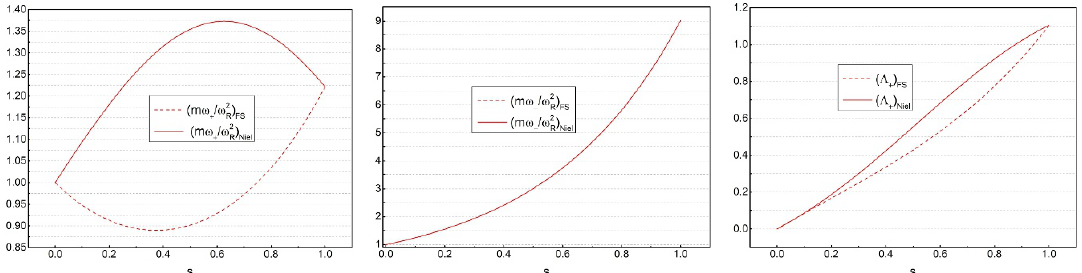
Figure 8 . Example of simple geodesics connecting the reference state to a same target state with a + nonvanishing, using Fubini-Study metric and Nielson approaches. In this particular example, we chose m ! + ( s = 1) = 1 : 221 ; m ! (cid:0) ( s = 1) = 9 : 025 ; (cid:3) + ( s = 1) = 1 : 105. (Recall from eq. ! 2 R ! 2 R